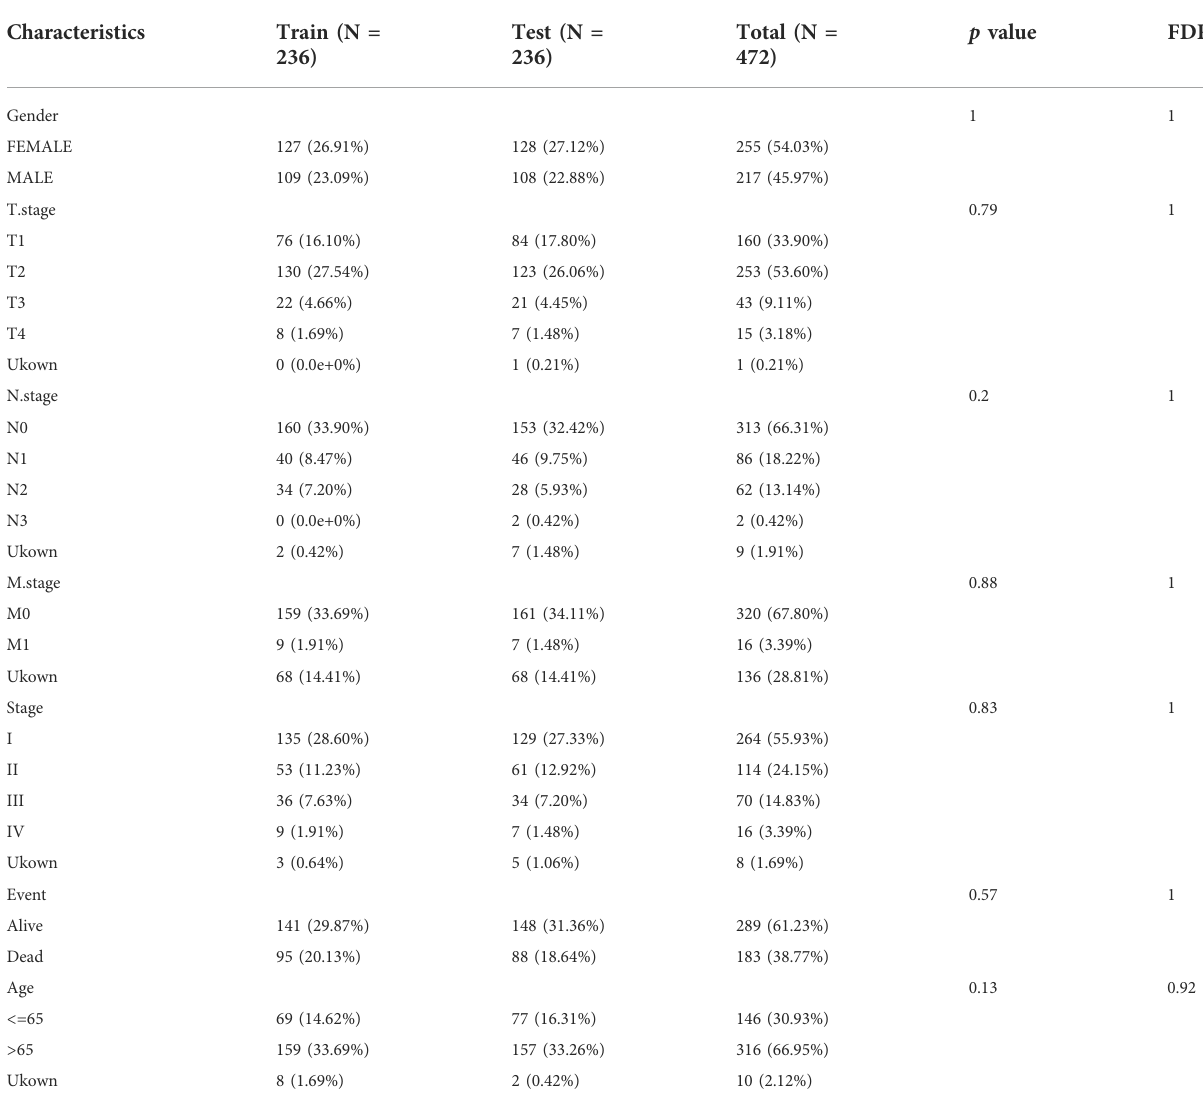
TABLE 1 Sample information of TCGA training dataset and validation dataset.